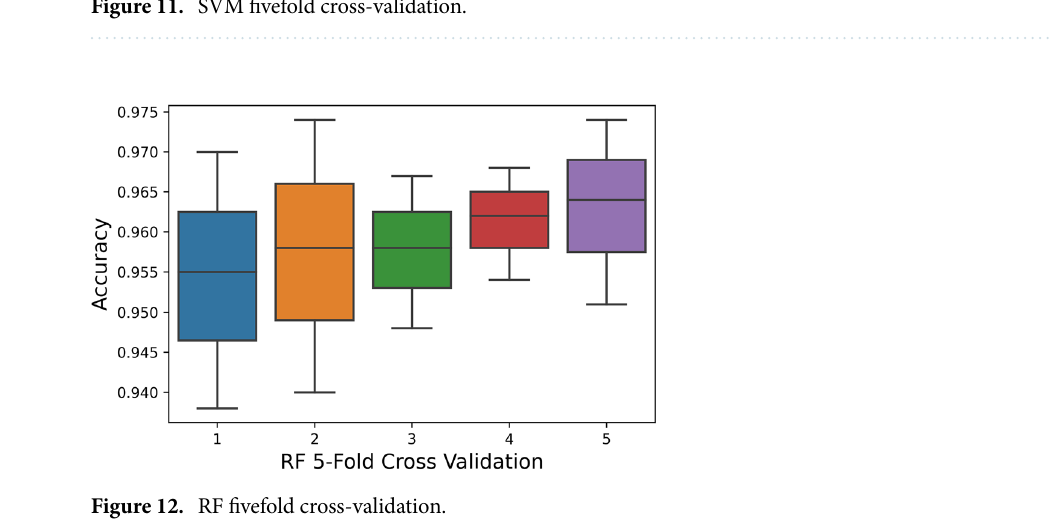
Figure 11. SVM fivefold cross-validation.